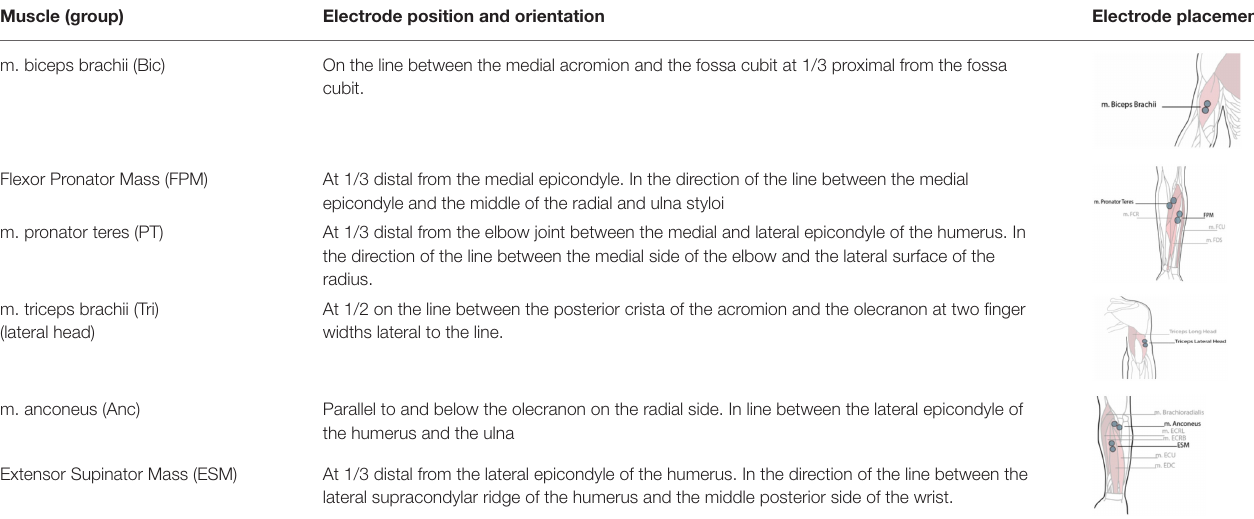
TABLE 1 | Electrode position and orientation. Muscle (group) Electrode position and